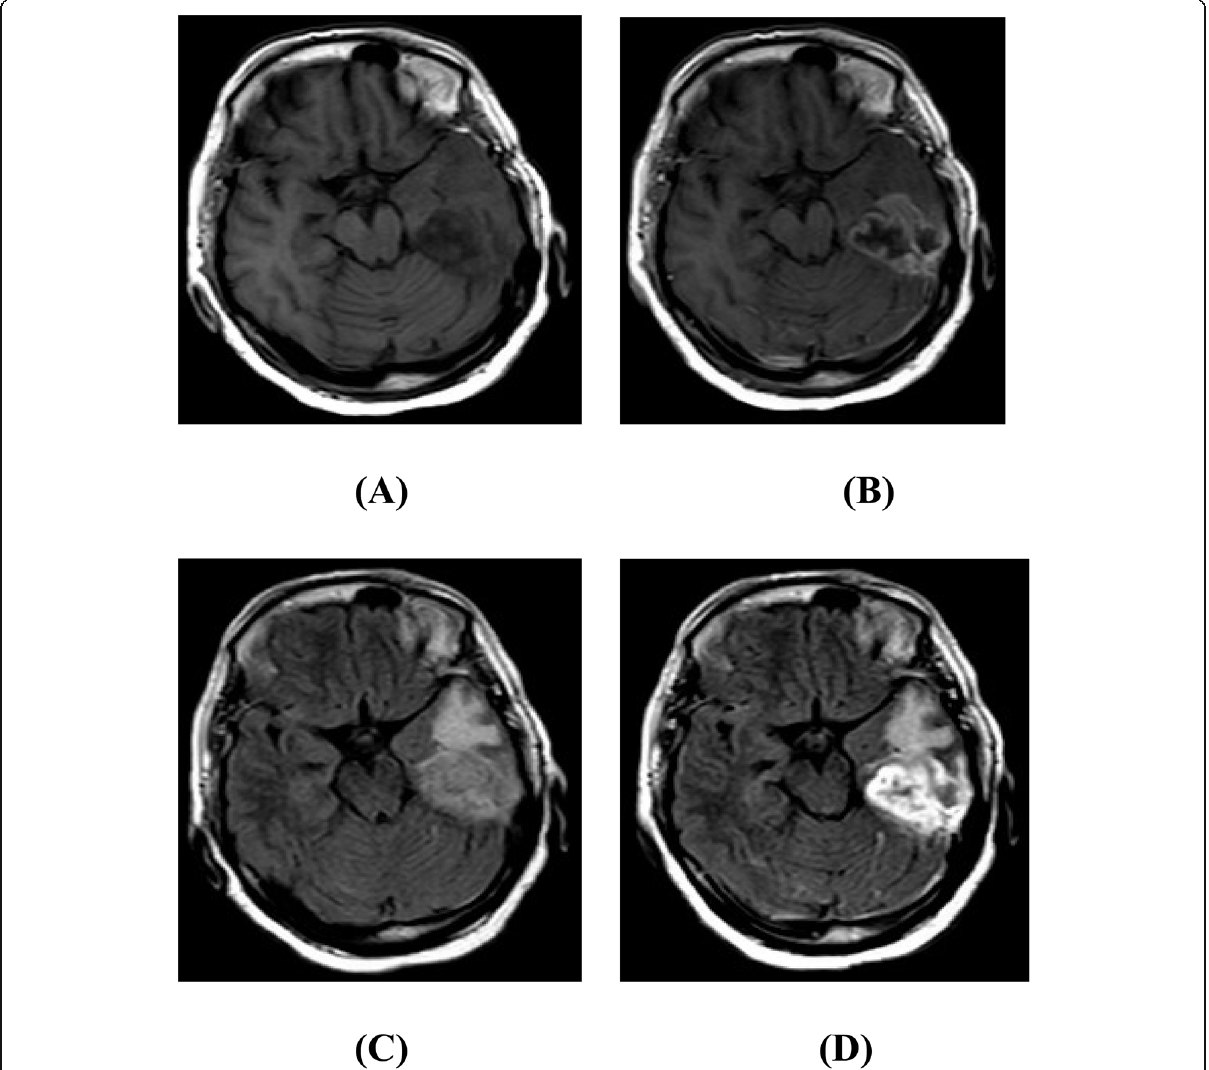
Fig. 6 Female patient aged 43 years histopathologically proven high-grade glioma. A , B axial pre- and post-contrast T1WI respectively showed intra-axial space-occupying lesion at left temporal lobe with irregular marginal enhancement. C , D Axial pre and post contrast FLAIR respectively showed thicker and more extensive enhancement of the lesion as well as better lesion to background signal intensity and overall contrast than in post-contrast T1WI. Also, good conspicuity of enhanced lesion margin from surrounding edema can be clearly